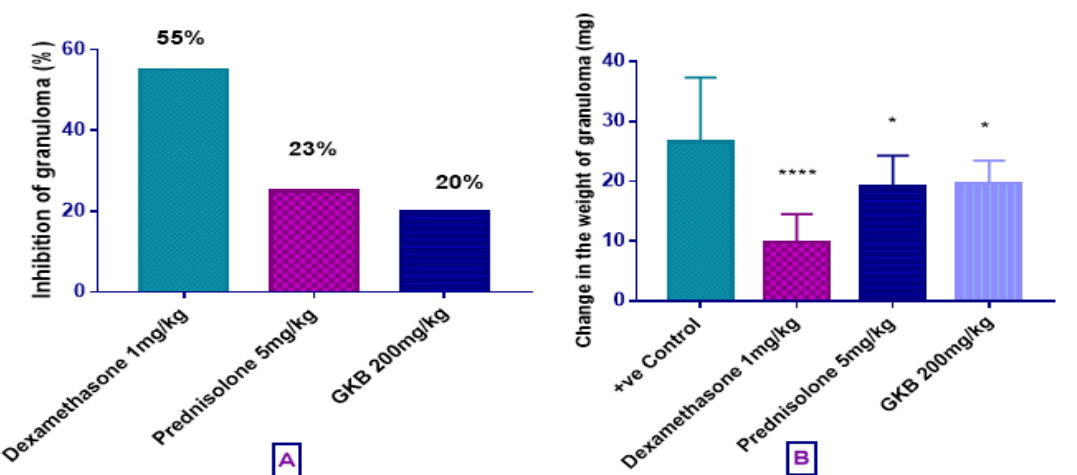
Figure 2: Effect of GKB extract on the percent (A) and weight (B) of granuloma in cotton pellet-induced granulomatous inflammation. Values were presented as mean ± S.D (n= 6 animals in each group); values with (*) are significantly different from the positive control using ANOVA and post hoc test (* p < 0.05), (** p < 0.01), and (*** p <